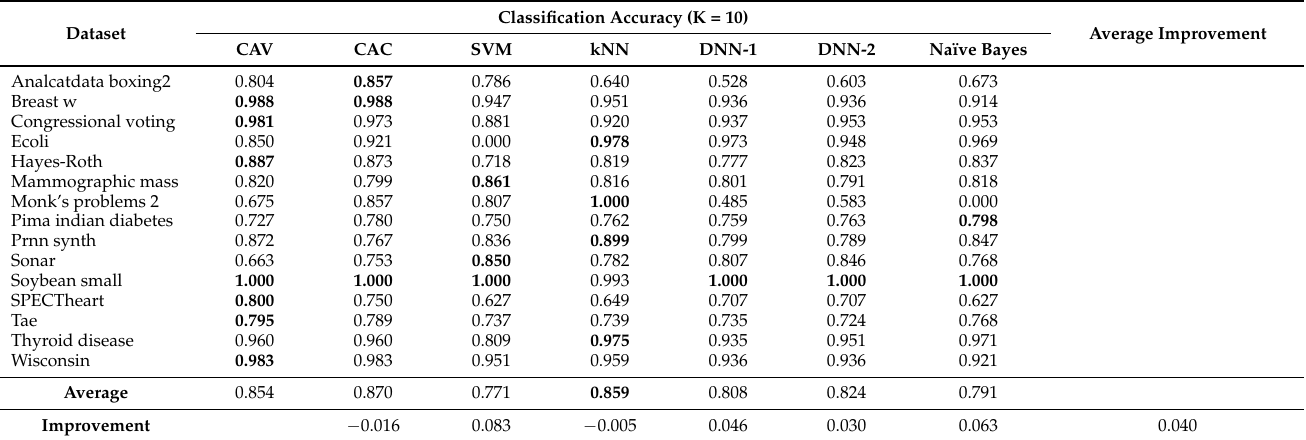
Table 8. The specificity of the proposed CAV compared with CAC, SVM, k-NN, DNN-1, DNN-2 and naïve Bayes (the bold number indicates the maximum value).